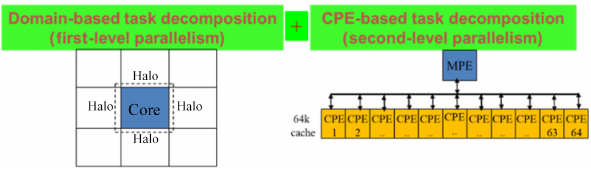
Figure 2. Illustration of the second-level parallelism of CPE-based task decomposition required on the Sunway heterogeneous many- core machine, which is additional to the first-level parallelism of domain-based task decomposition among core groups and the MPI parallelism as in the homogeneous multicore system.